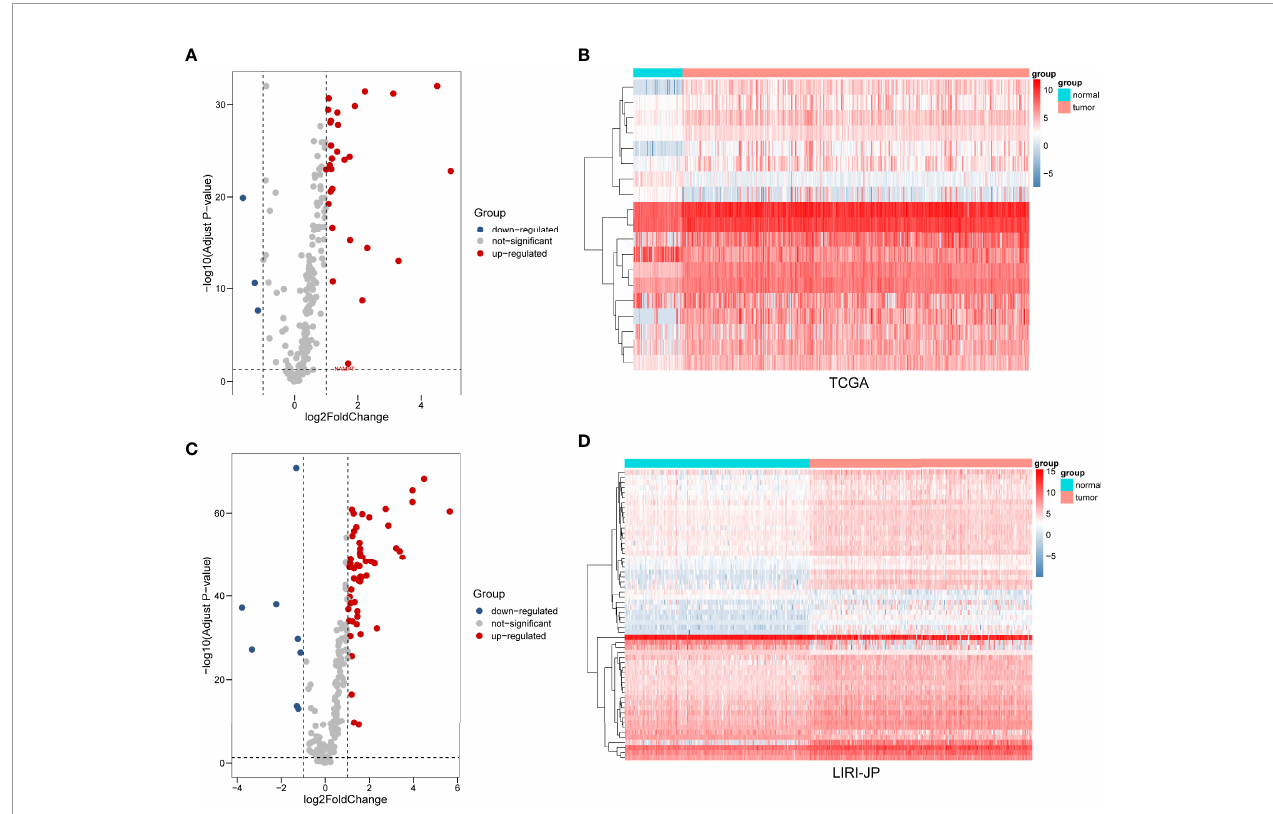
FIGURE 1 | Differential expression of autophagy-related genes (ARGs) between liver cancer and normal liver tissues in two databases. (A) The volcano plot and (B) clustering analysis of differentially expressed ARGs for TCGA database. (C) The volcano plot and (D) clustering analysis of differentially expressed ARGs for the ICGC database. Each point represents a gene. The red dots represent signi fi cantly upregulated ARGs, and the blue dots represent signi fi cantly downregulated ARGs. Each column represents one sample, and each row represents one